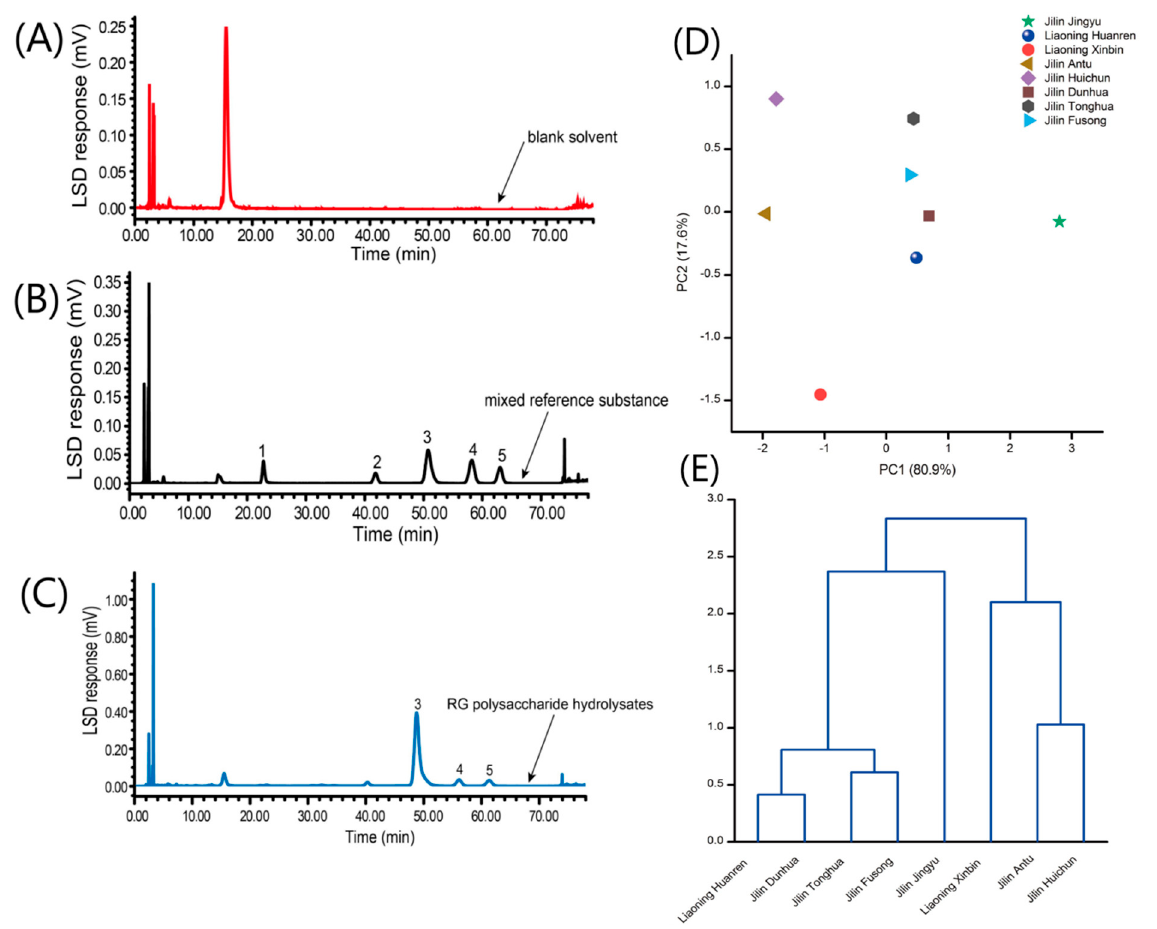
Figure 3. HPLC–PDA chromatograms of PMP derivatized blank solvent ( A ), mixed reference ( B ), RG polysaccharide hydrolysates ( C ); PCA ( D ) and cluster analysis ( E ) results of RG polysaccharide’s Scheme 1. mannose; 2, galacturonic acid; 3, glucose; 4, galactose; 5, arabinose. Table 3. Results of composition determination of RG polysaccharide.